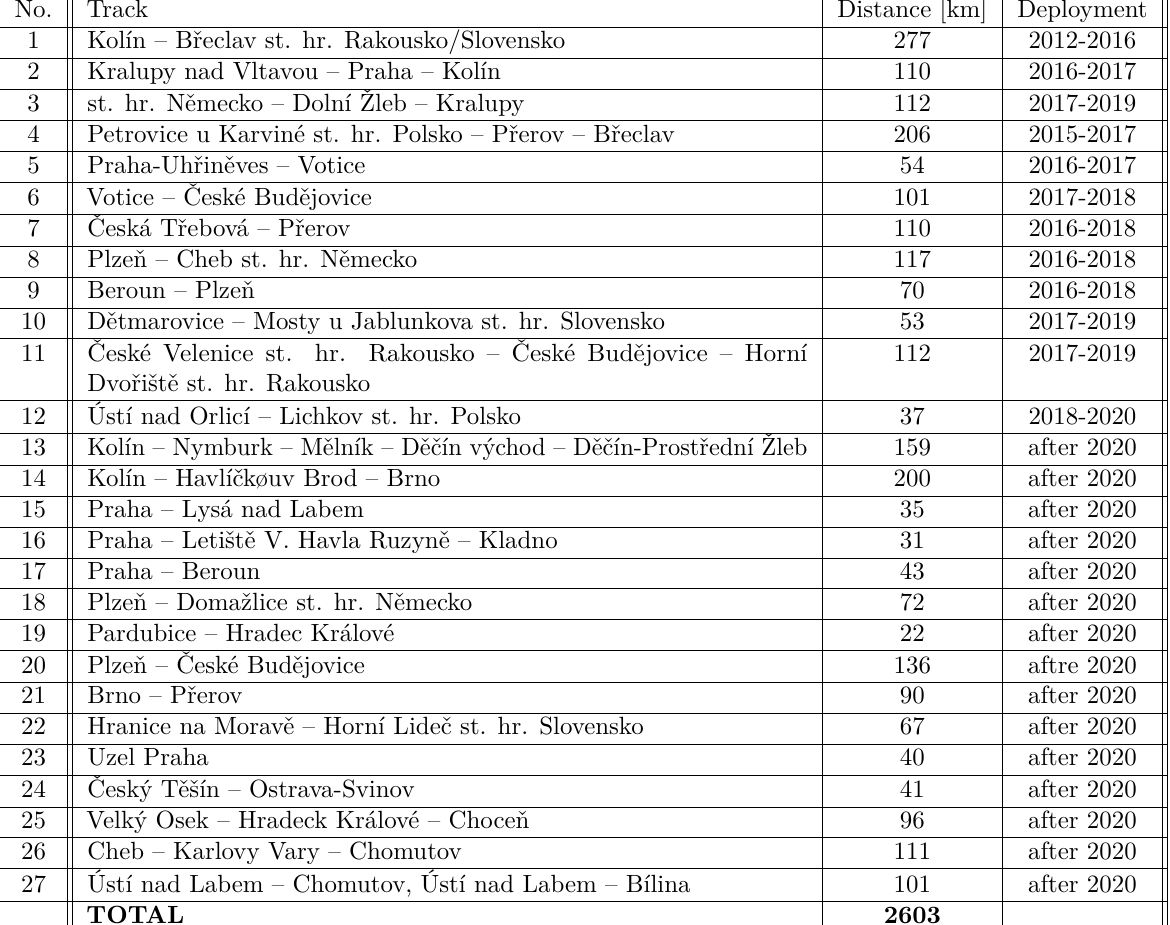
Table 2. Expected deployment of equipment upgrade ERTM/ETCS